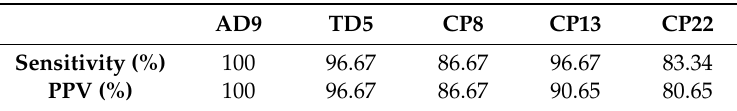
Table 2. Gait segmentation results of five